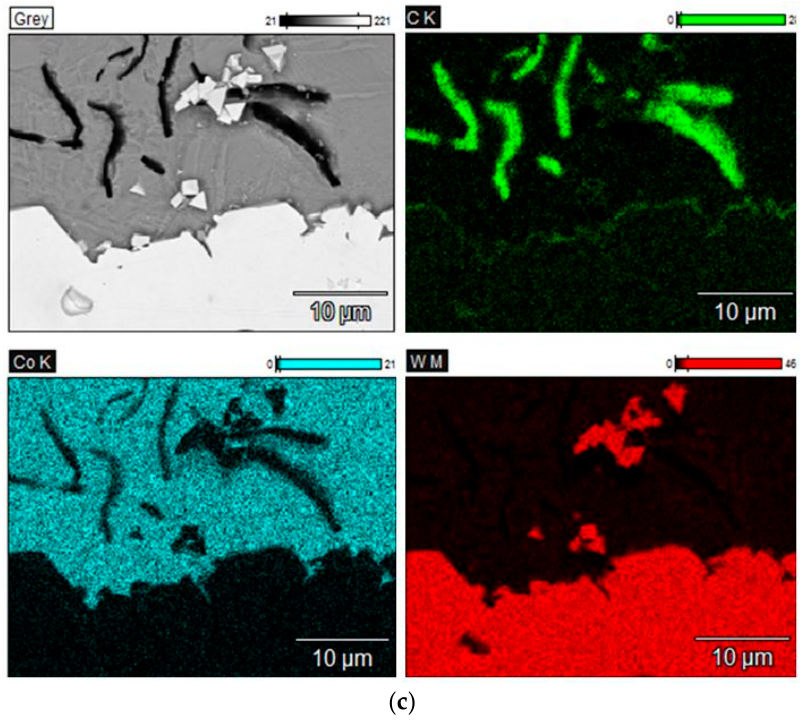
Figure 2. Scanning electron microscope (SEM) images and elemental maps of C, Co, and W in the interface region between the model binder alloys and polycrystalline WC samples: ( a ) Alloy with the low carbon content; ( b ) Alloy with the medium-low carbon content (precipitates of fine WC grains are indicated by arrows); ( c ) Alloy with the high carbon content.